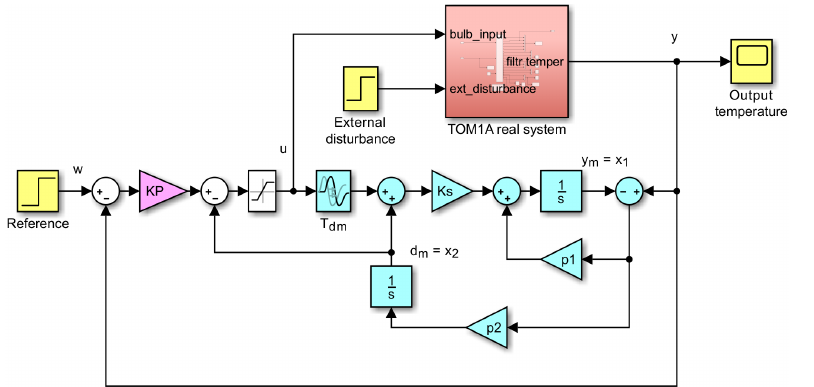
Figure 2. Control block scheme with ADRC 1 ( T d ) controller (modified ESO blocks with blue back- ground) derived for the model S 1 ( s ) , T d = T dm , y m displays y and d m displays d